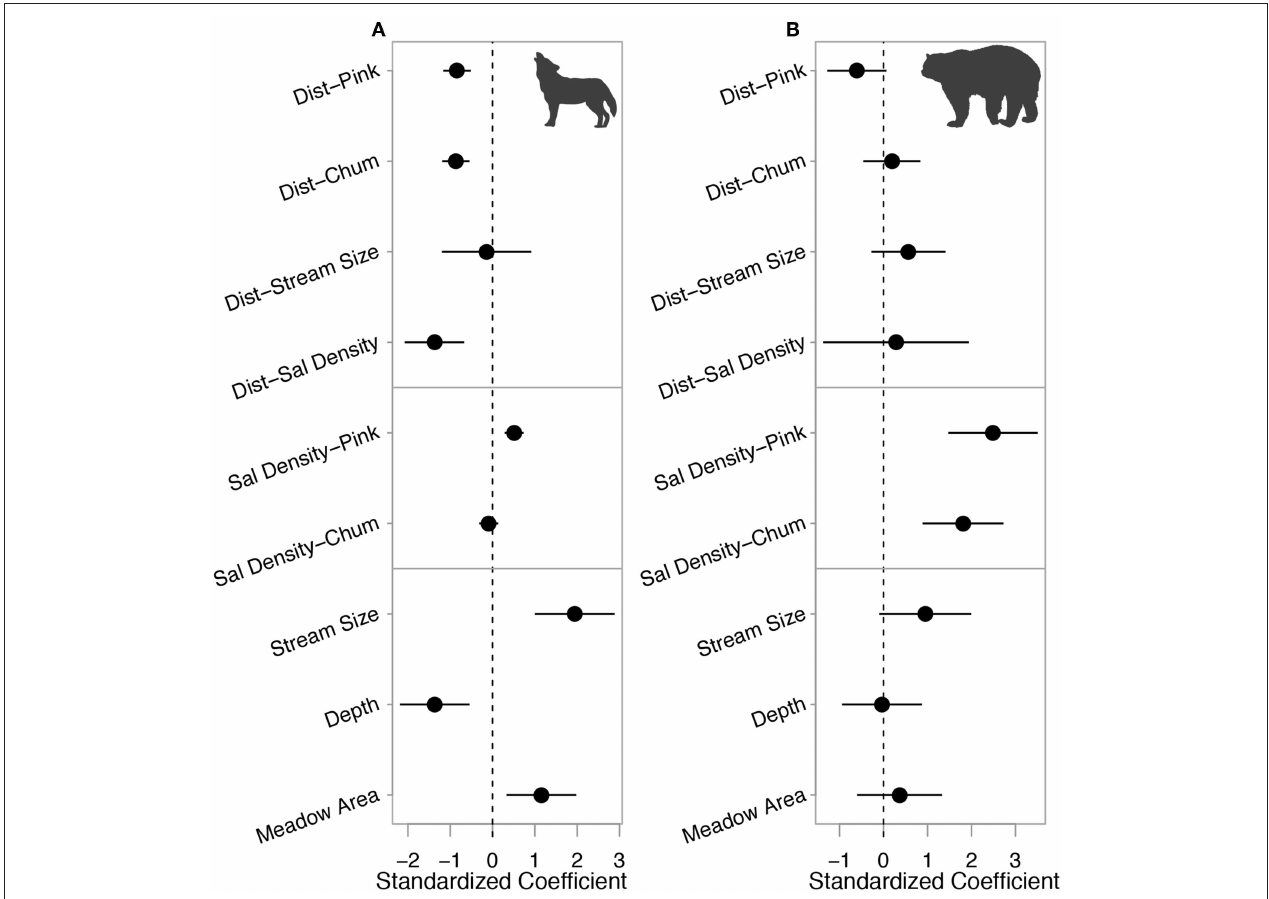
FIGURE 7 | Standardized coefficients (mean = 0, standard deviation = 2) with 95% confidence intervals for all covariates considered in the (A) wolf candidate model set and (B) bear candidate model set. Coefficient values indicate the average change in number of transferred carcasses per stream section as the associated covariate values increase by 2 standard deviations. Dist = distance upstream (km), Sal Density = salmon density (no./m 2 ), Stream Size = total spawning area (m 2 ). The top two rows show the relative effects of distance upstream on both wolf- and bear-transferred pink and chum carcasses as presented in Figures 6A,B . The two middle rows, isolated by horizontal lines, show the relative effect sizes of salmon density as presented in Figures 6C,D . Two variables separated by a hyphen indicate the effect of the interaction between those two covariates on wolf- or bear-transferred carcasses.